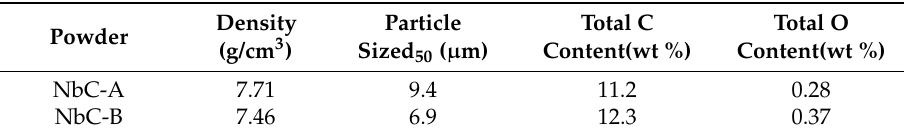
Table 1. Some characteristics of NbC starting